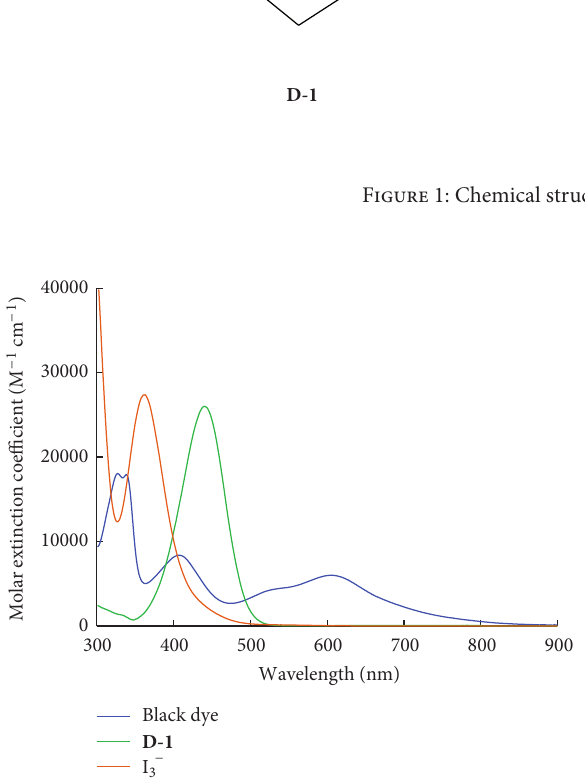
F3:UV-visibleabsorptionspectraofblackdye, D-1 ,andblack dye + D-1 (mix-dye) on TiO 2